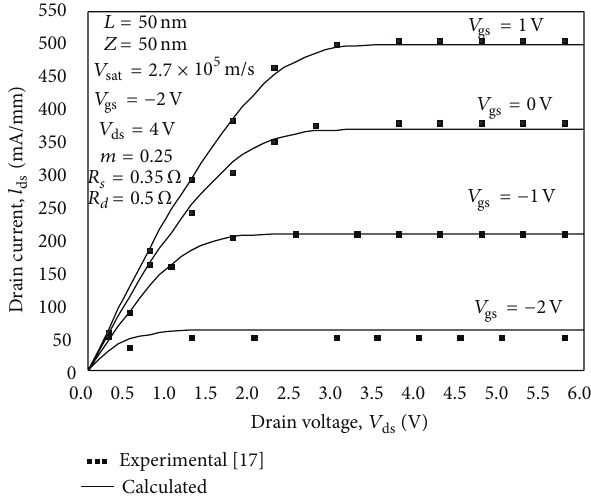
Figure 2: I-V characteristics of AlGaN/GaN